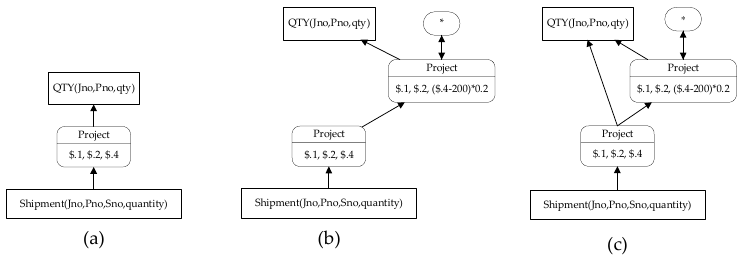
Figure 5. ( a ) Tuple provenance subgraphs of the tuple k 1 and k 4 . ( b ) Tuple provenance subgraphs of the tuple k 3 . ( c ) Tuple provenance subgraphs of the tuple k 2 and k 5 . Nodes contain actual parameter information. The relational table node generally contains metadata, such as field names, and the operation node includes the expression and a reference to the input values. “$. k ” refers to the k th field of the tuple, and in multivariate operations, “$i” and “$i. k ” refer to the ith tuple and the k th field of the tuple, respectively. Hereafter, we use the same notation related to provenance